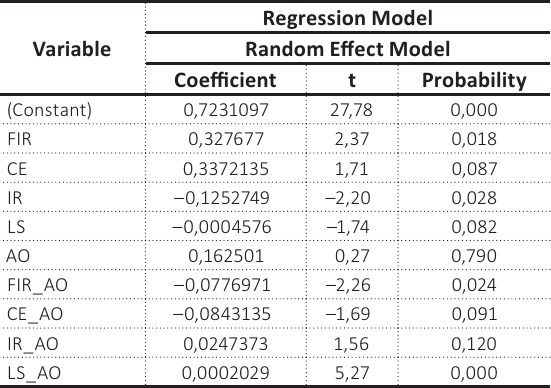
Table 5. Partial regression